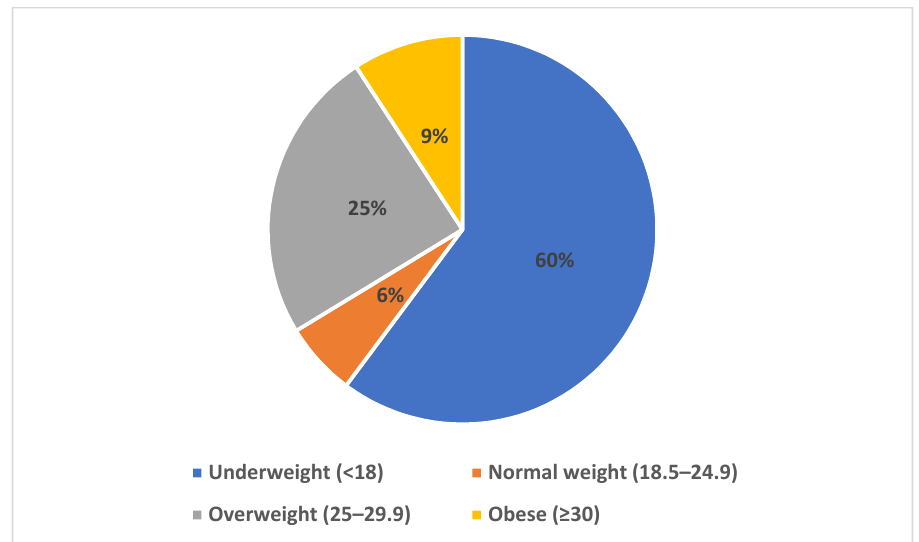
Figure 1. Distribution of participants according to four categories of BMI.